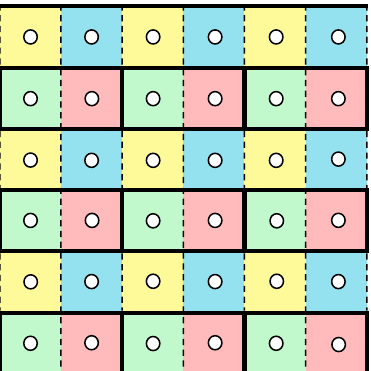
FIG. 7. The 2d square lattice is colored with four colors: yel- low, blue, red, and green. Yellow and red belong to the original “odd” faces, and blue and green belong to the original “even” faces. White dots represent fermionic modes inside faces. Com- pared with Fig. 5, qubits on the edges between yellow and blue faces will be stabilized by a single Pauli matrix after a certain unitary transformation so that they can be removed from the sys- tem. In the end, each solid line has one qubit, while there is no qubit on dashed lines.